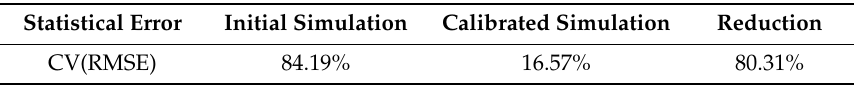
Table 4. Values of the CV(RMSE) for the initial simulation and after the calibration of the simulation.